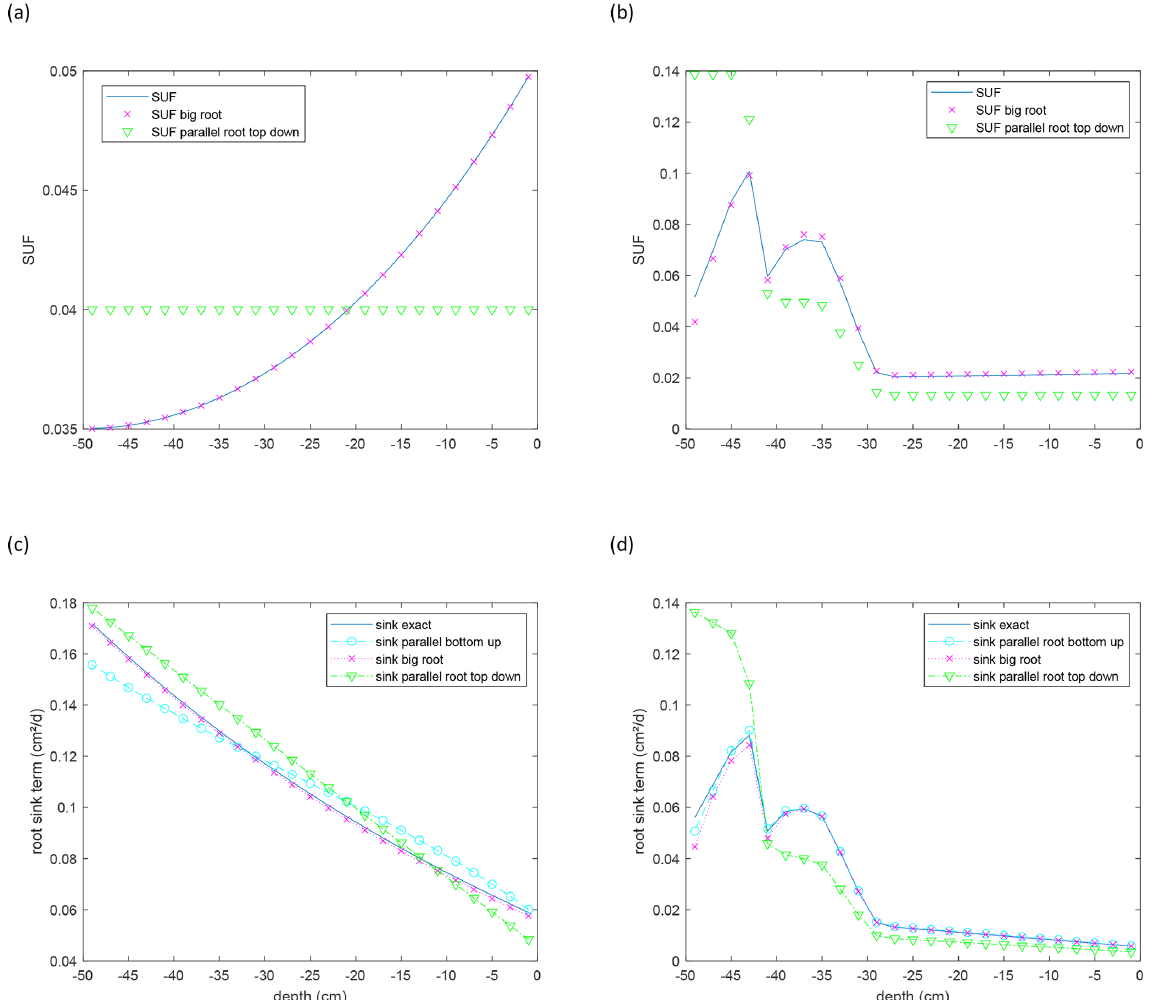
Figure 7. Standard uptake for homogeneous soil water potential ( SUF ) (a, b) and root sink term for a linear increase in water potential with depth (c, d) of a single root branch with uniform (a, c) and age-dependent (b, d) root segment conductances. Approximations are calculated for the parallel root with a bottom-up parameterization using the exact SUF and K rs , the big root model, and parallel root model with a top-down parameterization, with SUF estimated from the radial root segment conductivities. Sink terms are divided by the thickness of the soil layer, 2cm, over which the root segment sink terms are